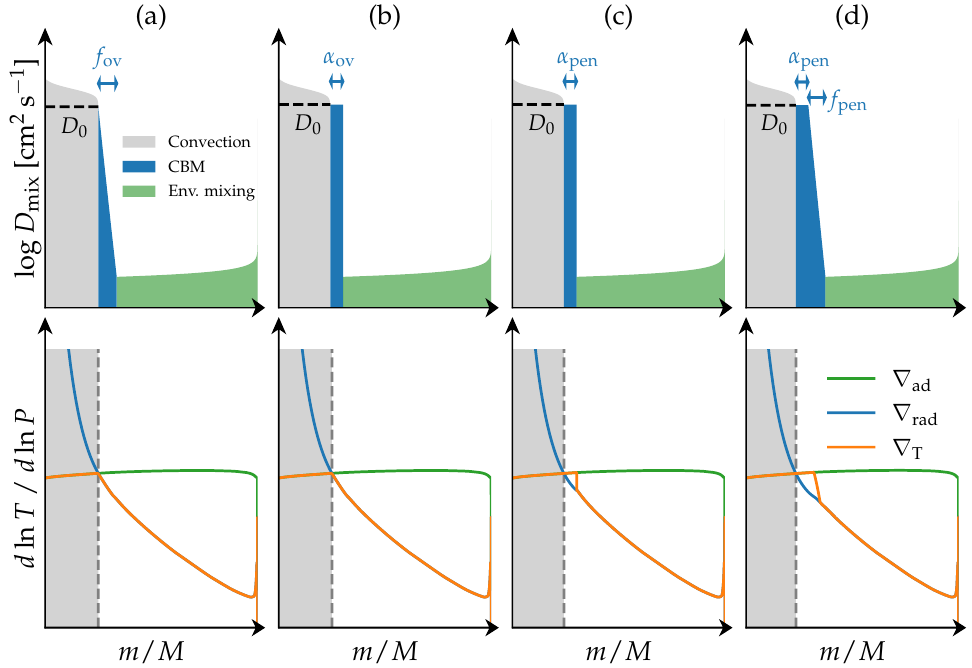
Figure 2. Illustration of four different convective boundary mixing prescriptions in 1D. Internal mixing profiles are shown in the top panels, while the corresponding temperature gradients are given in the bottom panels. ( a ) Exponential diffusive overshoot, ( b ) step overshoot, ( c ) convective penetration, and ( d ) extended convective penetration. Convective regions are indicated in gray. D CBM ( r ) and D env ( r ) are shown, respectively, in blue and green in the top panels. In the bottom panels, the plotted curves show the adiabatic temperature gradient (green), the radiative temperature gradient (blue), and the adopted temperature gradient (orange). Figure made by the authors using MESA models . The data used to generate the figure are available on Zenodo